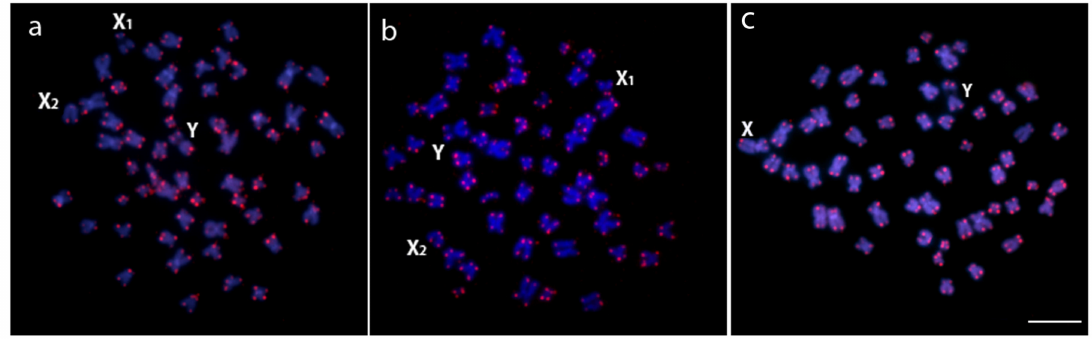
Figure 4. Male metaphase plates of H. duriventris ( a ), H. villasboas ( b ) and H. rondoni ( c ) showing telomeric hybridization signals on both telomeres of all chromosomes. Bar = 5 µ